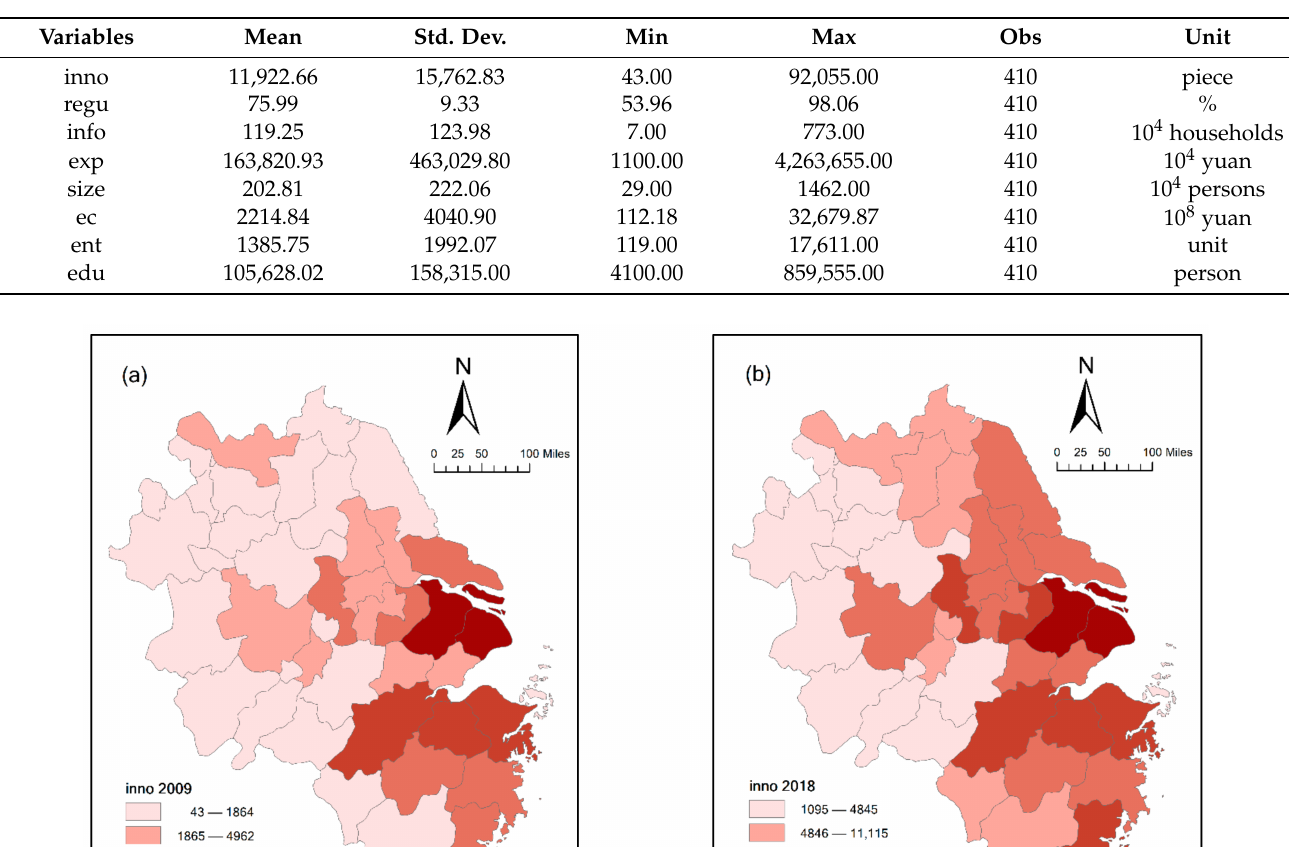
Table 5. Descriptive statistics of the variables.